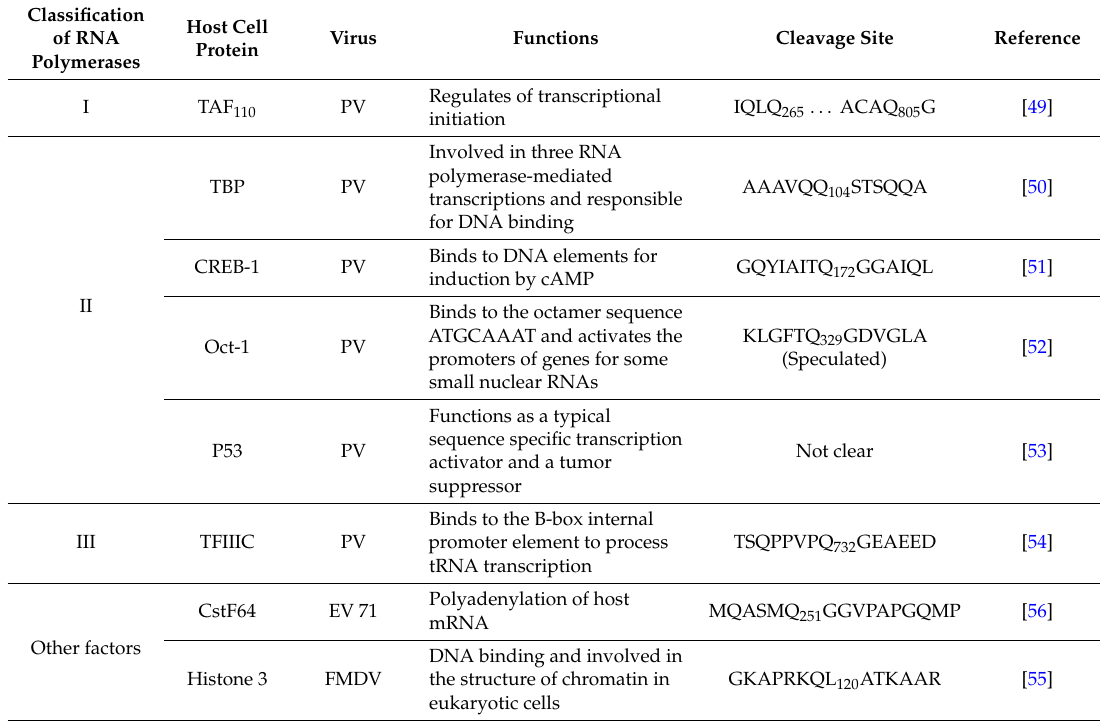
Table 1. Cleavage of cellular transcription factors by 3C pro